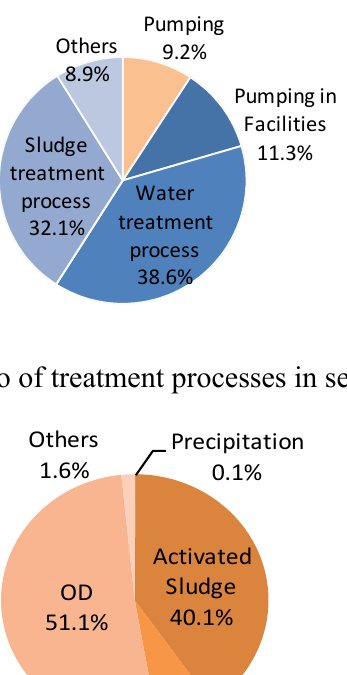
Figure 9. Energy consumption ratio of sewer systems in Japan.